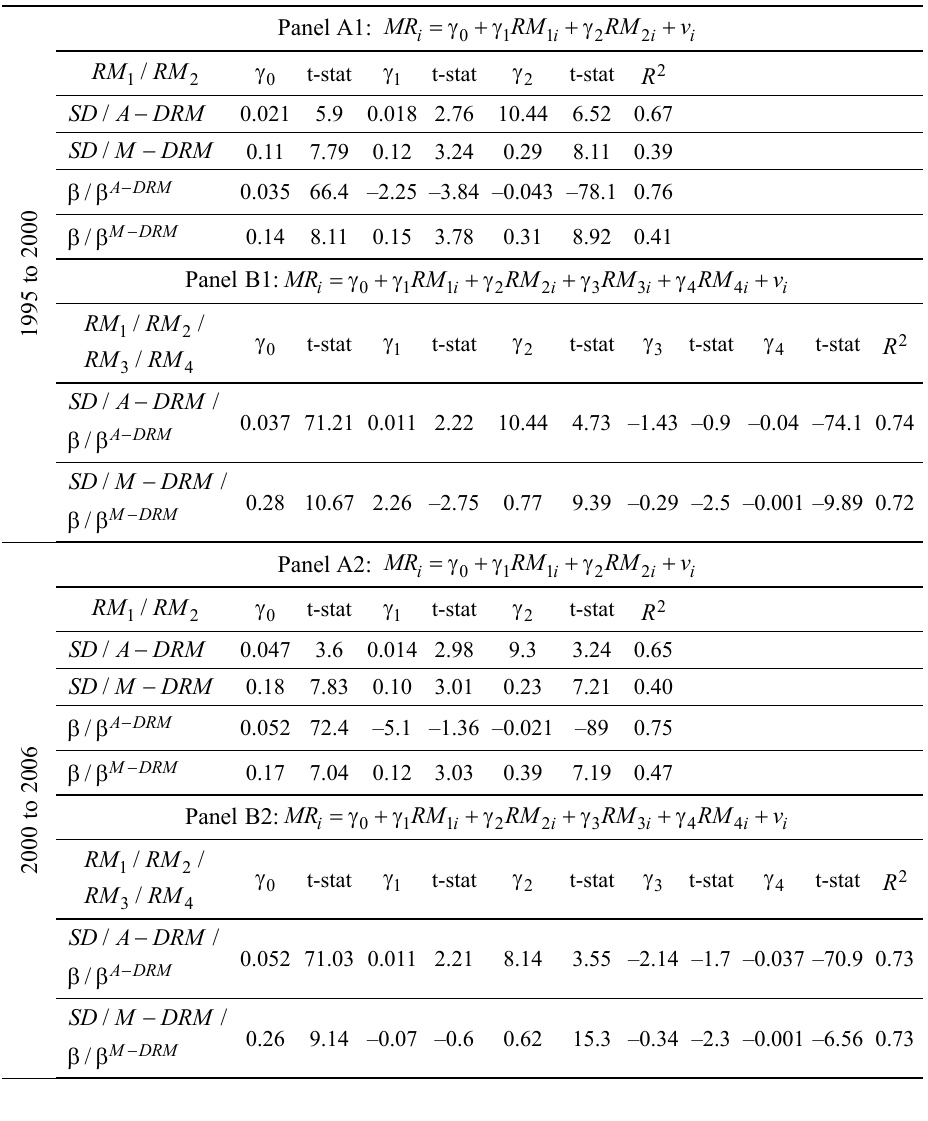
Table 8. Result of robustness